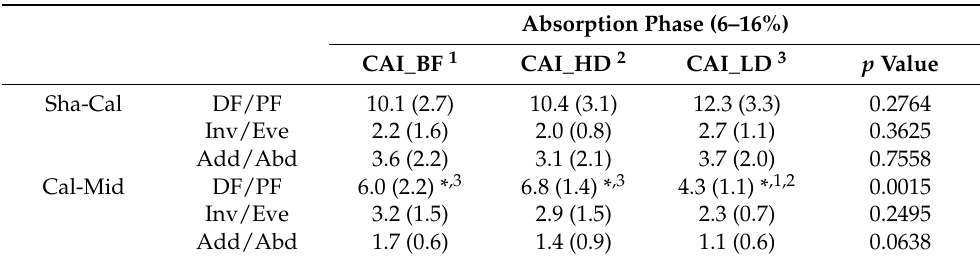
Table 4. Summary of mean RoM and standard deviation (in degrees) during absorption phase in CAI_BF versus CAI_HD versus